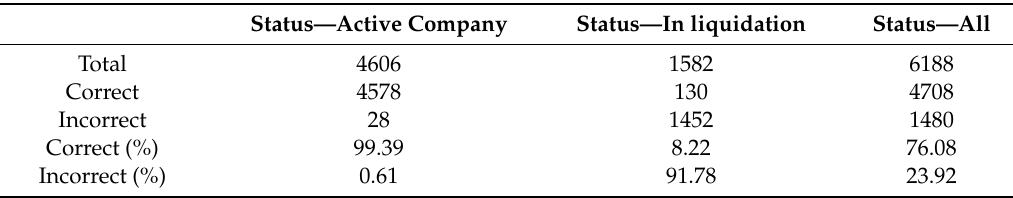
Table 3. SVM model prediction